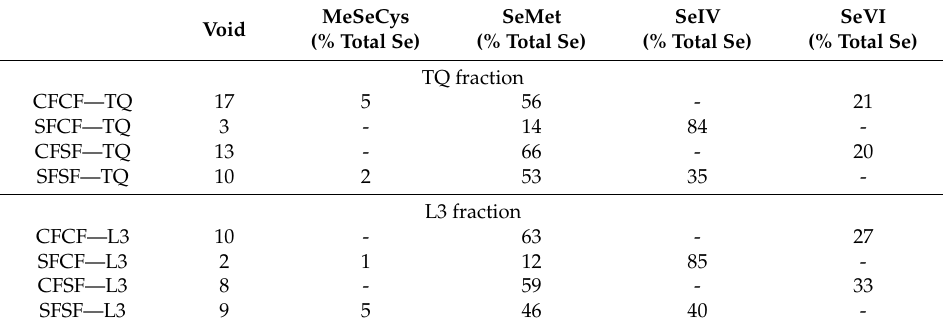
Table 3. Se speciation: percent distribution of the different Se species in GI hydrolysates.